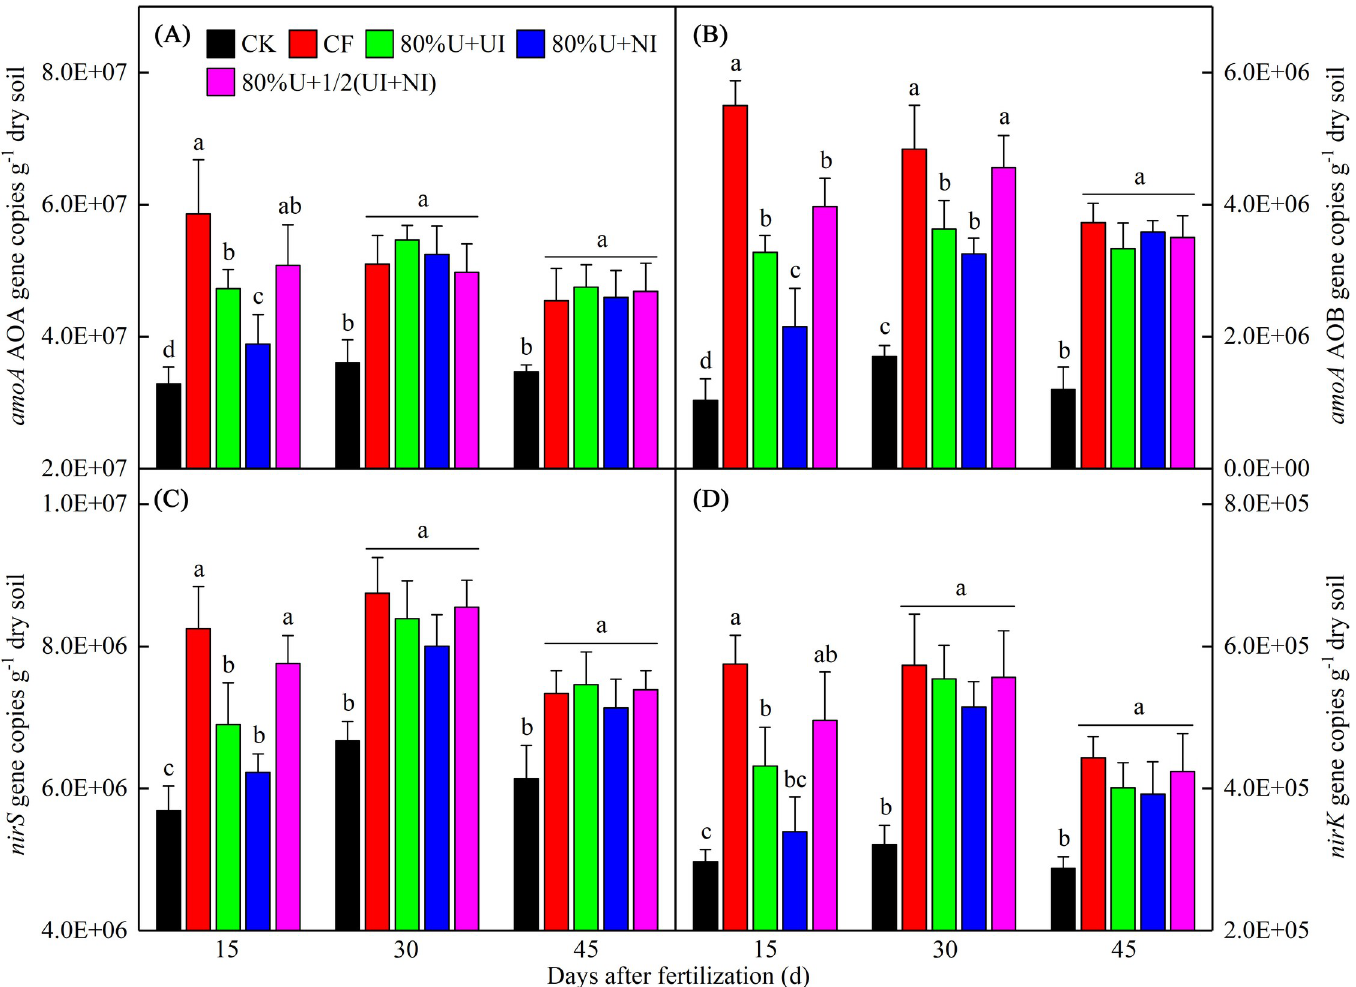
Fig 3. The N-cycling gene copies under different fertilization treatments. CK, no N fertilizer input; CF, conventional fertilization; 80%U+UI, 80%U+NI and 80%U+1/2 (UI+NI) indicate 80% of urea input with NBPT, with DMPP and with half NBPT and half DMPP, respectively. Different lowercase letters above the bars represent significant differences ( p < 0.05) between